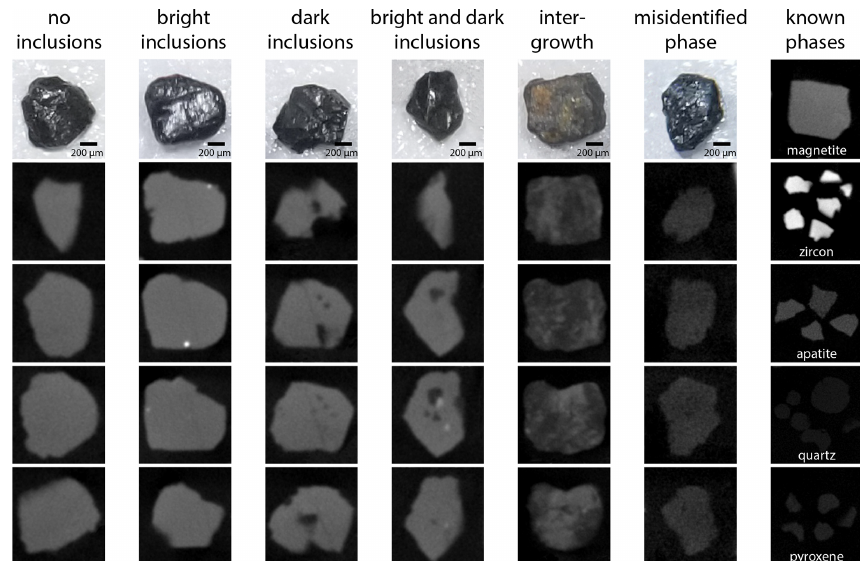
Figure 4. Examples of textures and inclusions in magnetite grains detected with microCT. Light micrographs and four horizontal microCT slices through the same grain are given in each column. All microCT scans were acquired with the same scan parameters, and images are given at the same contrast. Reference microCT images for known phases are given for comparison (magnetite as confirmed by FTIR, SLI 3 zircon, Durango apatite, and CRONUS quartz and pyroxene standards). Bright inclusions represent zircon and apatite, whereas inclusions darker than magnetite are most likely silicates. Intergrowth and substitution structures as well as other phases mistakenly identified as magnetite during sample picking under a light microscope were also detected. Table 1. Elemental analyses of bulk soil samples and mineral separates by ICP-MS. Only the most relevant parameters for determining neutron fluxes and 3 He production rates are shown; full results can be found in the EarthChem database. Sample Depth